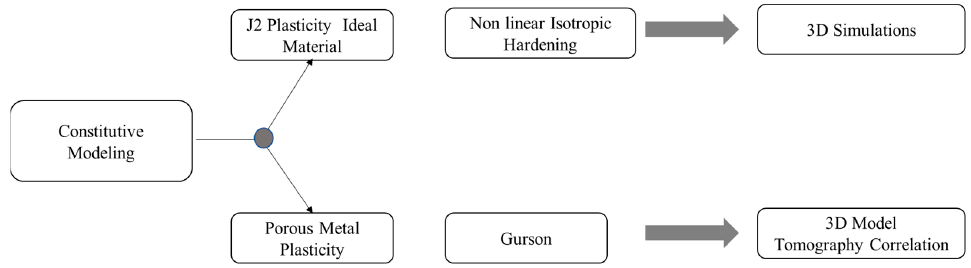
Figure 4. Plasticity and Porous Plasticity FE Modeling Scheme .